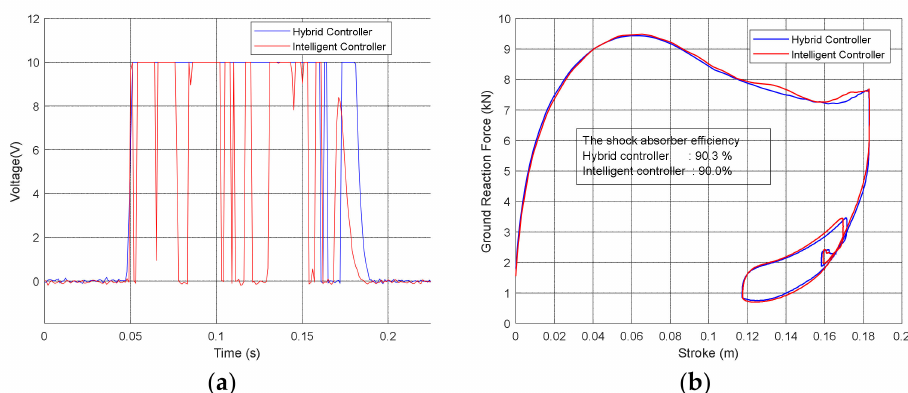
Figure 12. ( a ) Voltage applied to MR core, ( b ) efficiency curve. The drop test results of the landing gear using the hybrid controller with exact information and intelligent controller in the case of m 1 = 210 kg, v = 3 m/s (testing case).